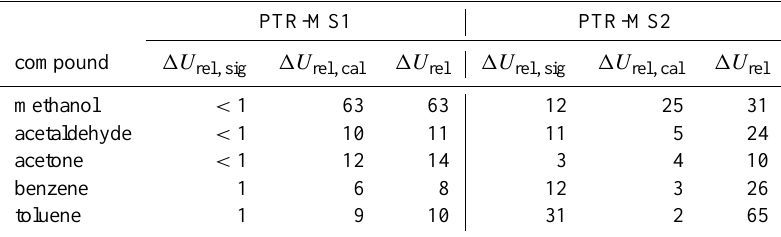
Table 2. Uncertainty values for a single measurement point for PTR-MS1 and PTR-MS2. Uncertainty of the signal statistics ( (cid:49)U rel, sig ) includes both uncertainties of the measured signal and the background signal. (cid:49)U rel, cal is the relative uncertainty of the sensitivity. The total uncertainty, (cid:49)U rel , includes an additional 5%, the concentration uncertainty of the calibration gas standard, which was constant for all the compounds. All the values are presented in percentages.